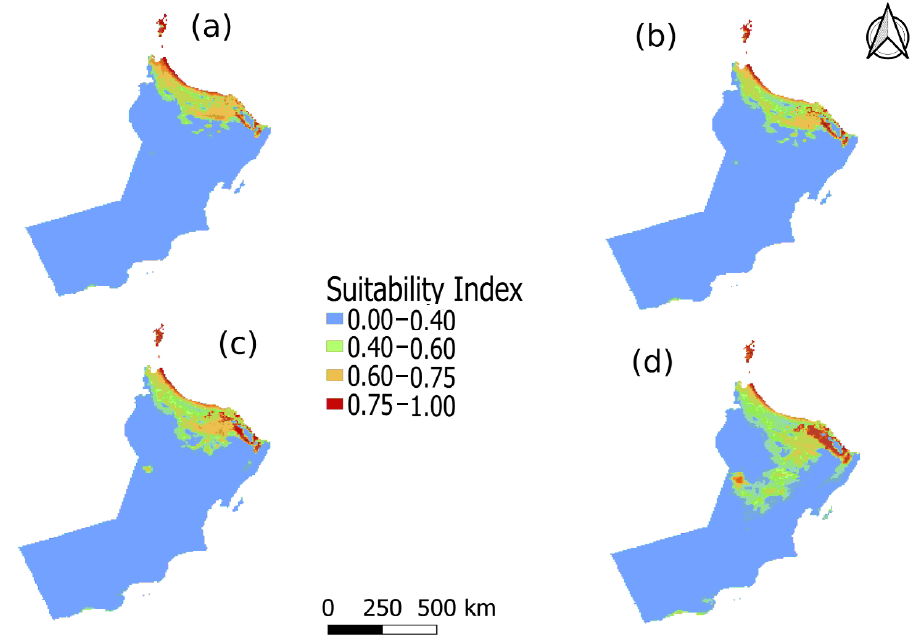
Figure 3. Potentially suitable climatic distribution of 16SrII-B phytoplasma under different climate-change scenarios in Oman for ( a ) 2021–2040, ( b ) 2041–2060, ( c ) 2061–2080, and ( d ) 2081–2100.